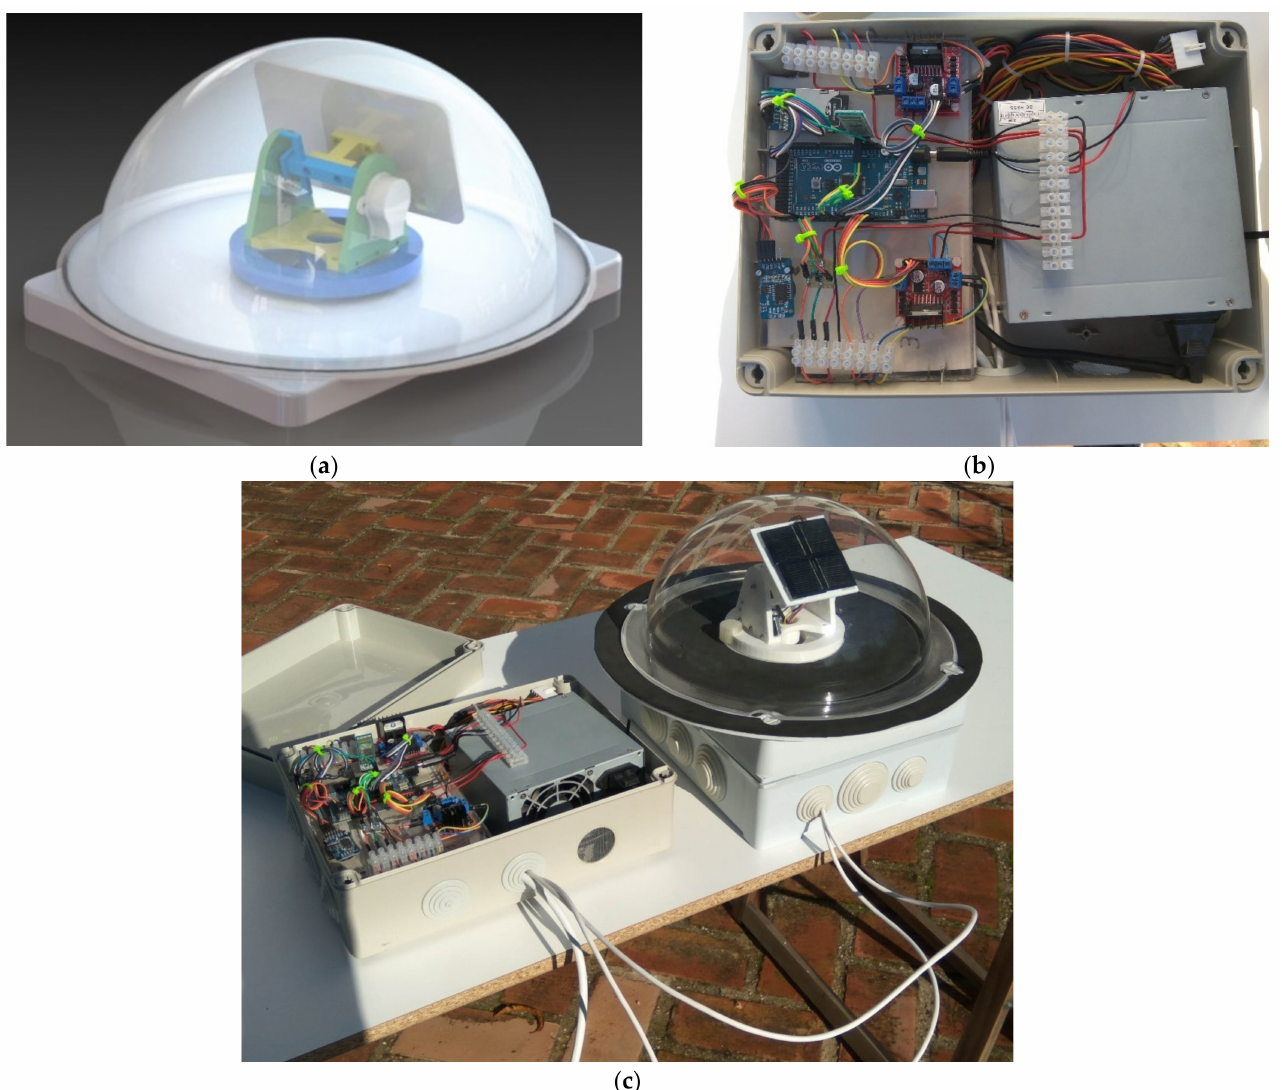
Figure 4 schematically shows the concept of the electronic design of the system in which four blocks are distinguished: sensors, processing, actuators and